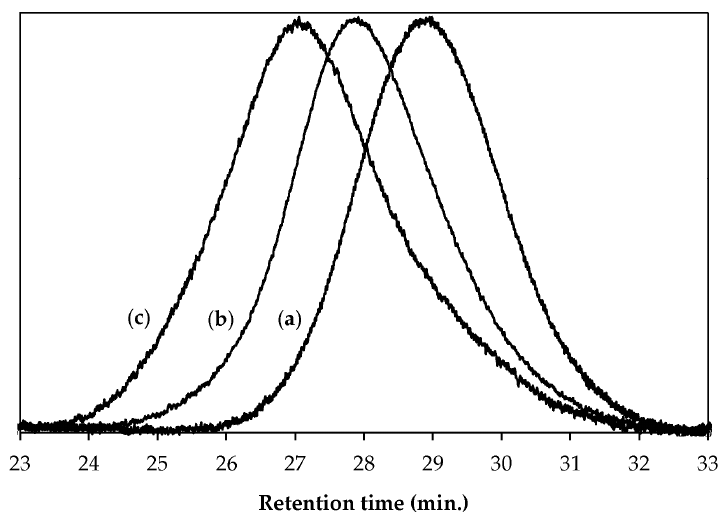
Figure 4. SEC chromatograms of ( a ) PNVCL–OH, ( b ) PNVCL- b -PCL (1) and ( c ) PNVCL- b -PCL (2). Table 2. Summary of the main characteristics of the PNVCL- b -PCL block copolymers obtained by ROP of ε -CL.